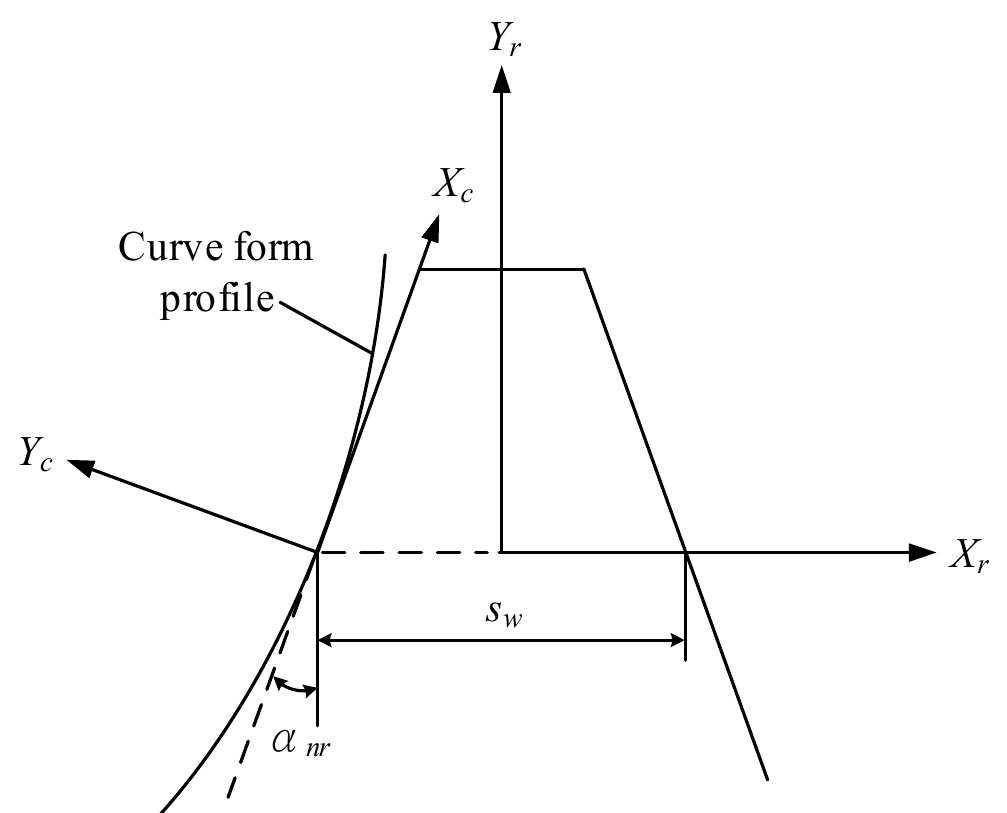
Figure 8. Profile of the rack for correcting the shaping cutter.